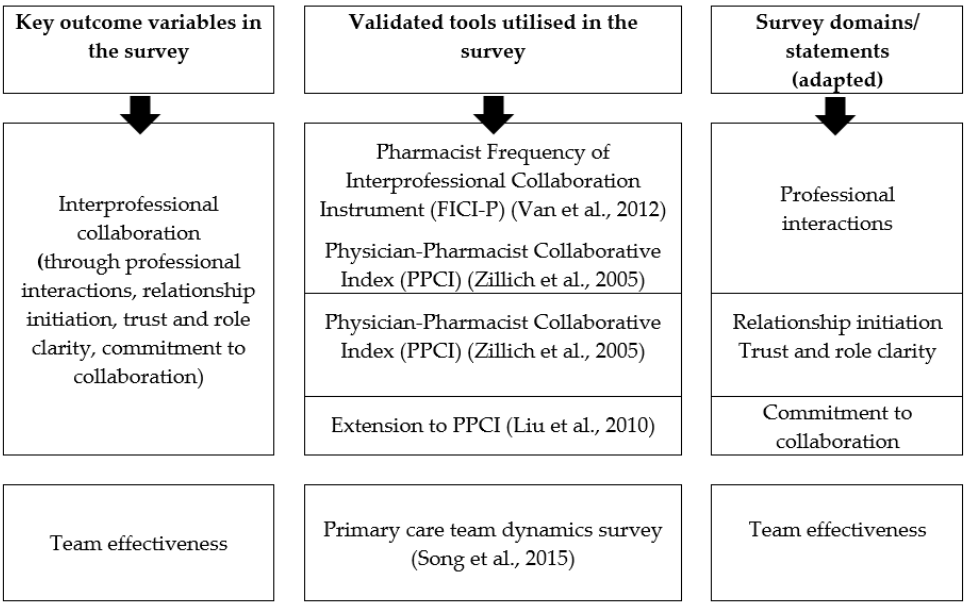
Figure 1. Development of survey instruments [34–37].